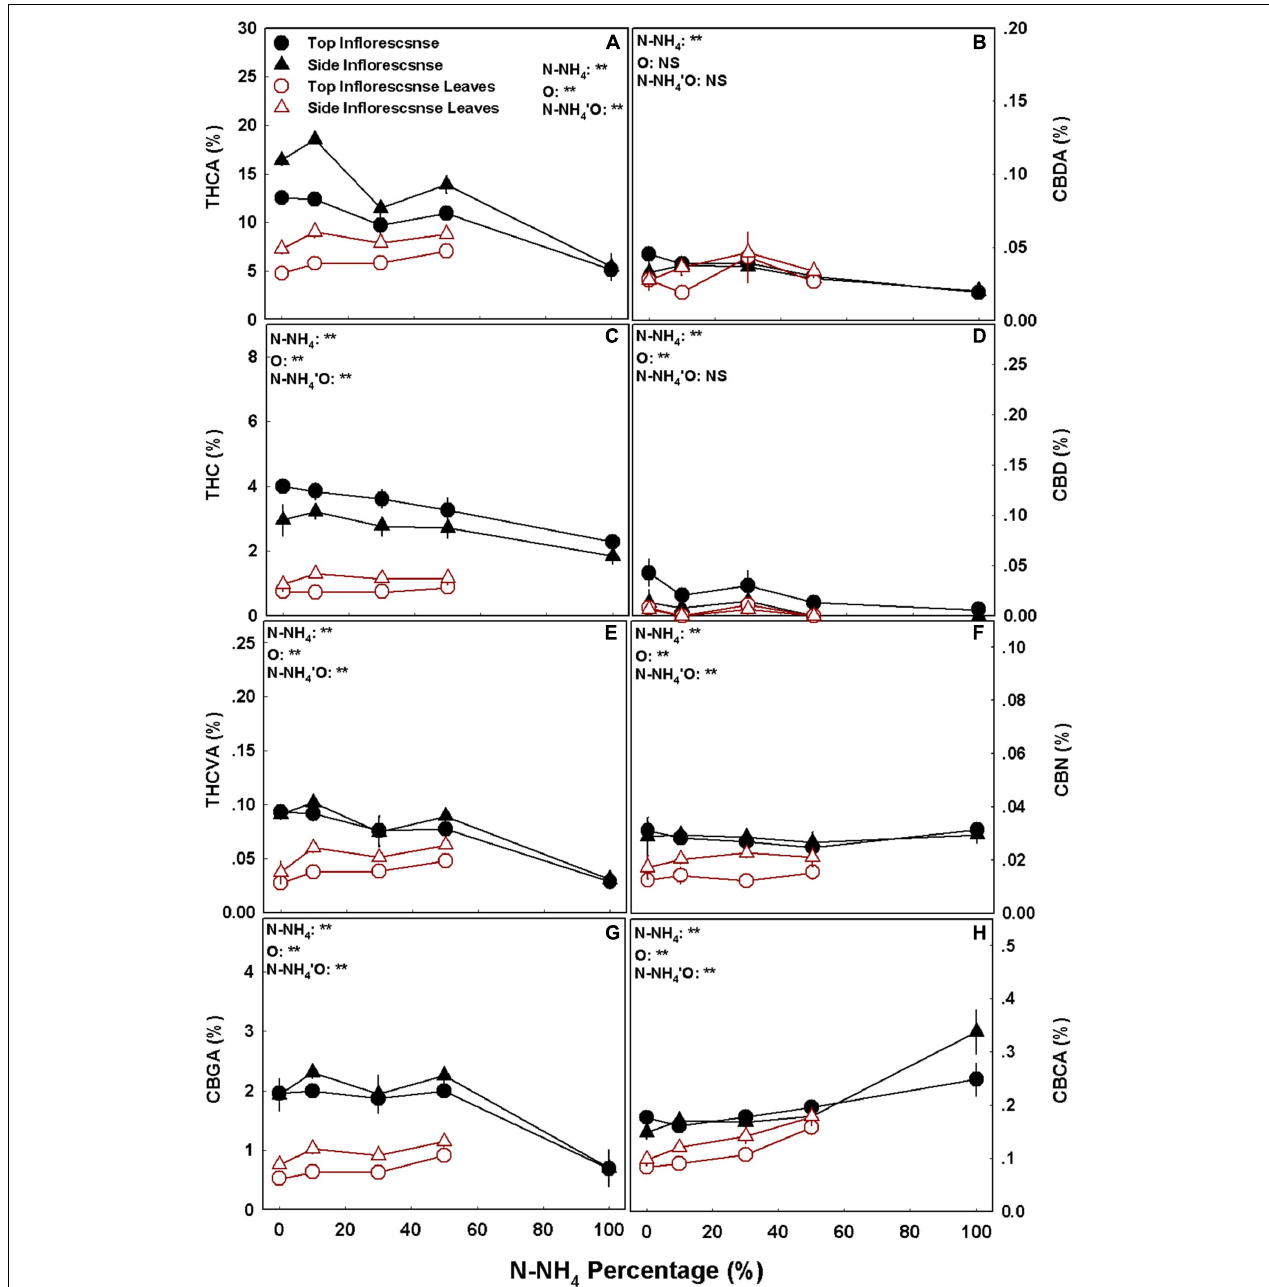
FIGURE 4 | Effect of NH 4 /NO 3 ratio on cannabinoid concentrations in medical cannabis plants. Concentrations of THCA (A) , CBDA (B) , THC (C) , CBD (D) , THCVA (E) , CBN (F) , CBGA (G) , and CBCA (H) in top (primary) and side (secondary) inflorescences and inflorescence leaves. Presented data are averages ± SE ( n = 5). Results of two-way ANOVA indicated as ** P < 0.05, F -test; NS, not significant P > 0.05, F -test. In the ANOVA results N-NH 4 ’O represents the interaction between NH 4 /NO 3 ratio and plant